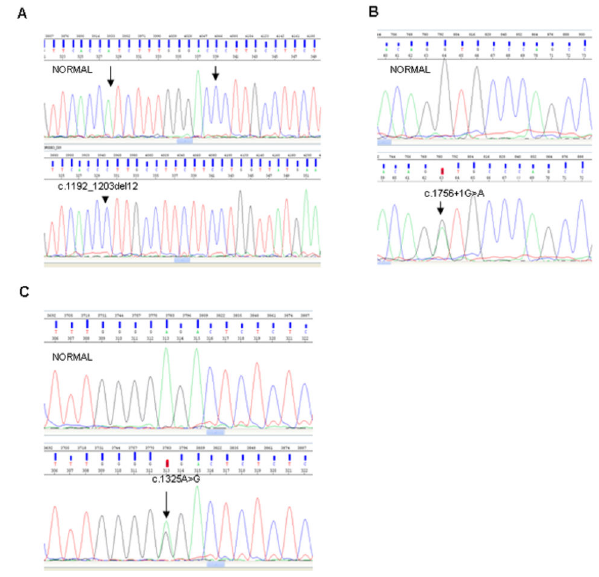
Figure 2. Detection of novel CLCNKB mutations by direct sequencing. Figures represent the sequencing chromatograms from controls (upper panels) and patients (lower panels). (A) Heterozygous c.1192_1203del12 mutation in exon 12; arrows show the extension of the deletion. (B) Heterozygous c.1756+1G>A mutation at the splicing site in exon 16. (C) Heterozygous missense mutation c.1325A>G in exon